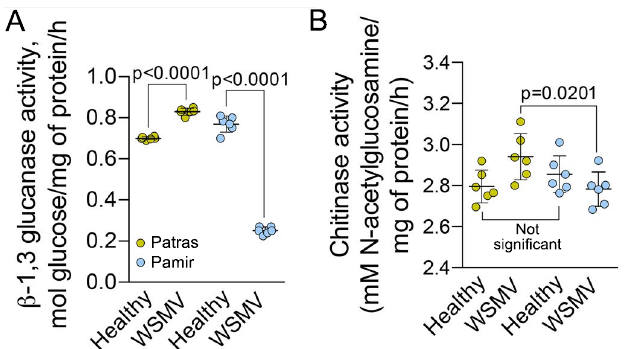
Figure 6. Impact of WSMV infection on activity of pathogenesis-related proteins. ( A , B ), Activity of β -1,3-glucanase ( A ) and chitinase ( B ) in leaves of healthy or WSMV-infected plants. Six biological replicates (individual plants) were measured per each treatment. p values were calculated using non-paired t